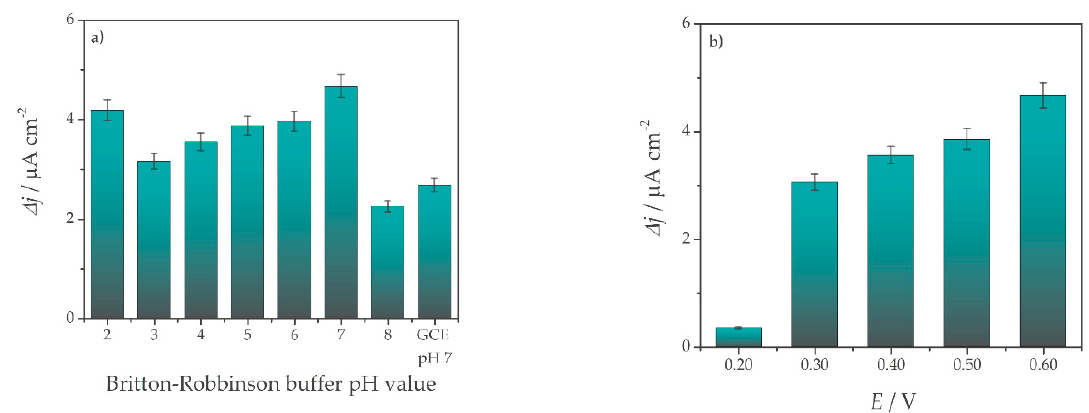
Figure 3. The chronoamperometry (CA) response of 50 µM 5-ASA in 0.04 M BR buffer with PMB DES /GCE. ( a ) For different pH values (pH 2.0–8.0), E = +0.60 V; ( b ) For different applied potentials ( E = +0.20 − +0.60 V), BR buffer pH 7.0.